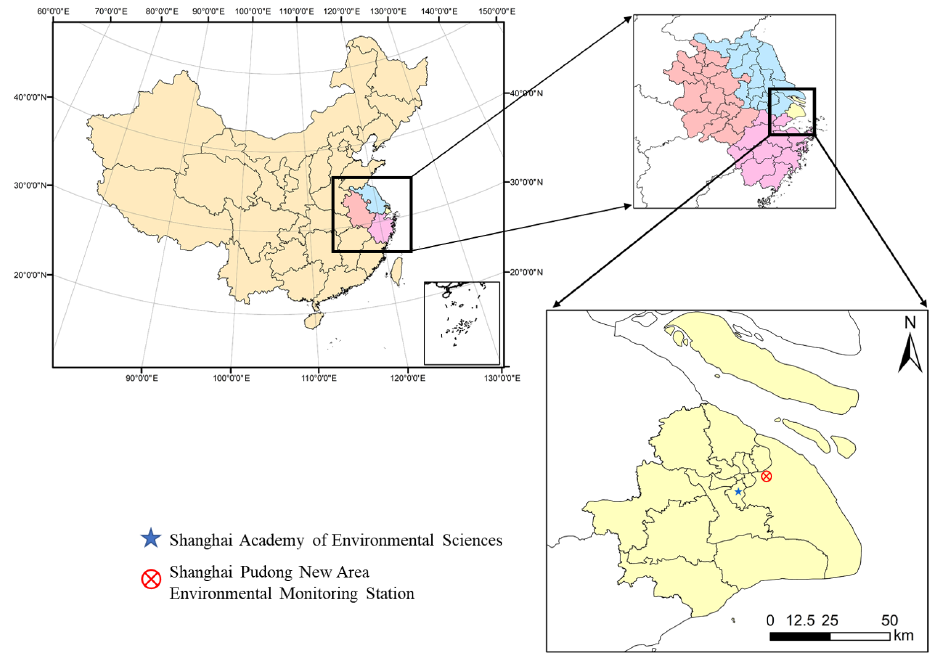
Figure 1. Location of the two sampling sites in Shanghai, China.